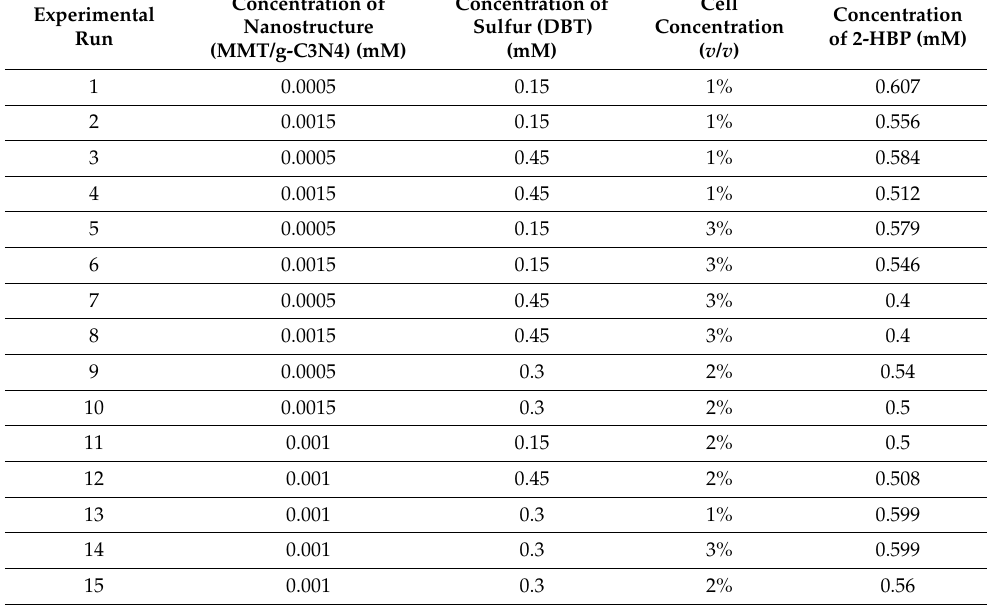
Table 2. The results of CCD for three factors (concentration of nanostructure (MMT/g-C3N4), concentration of sulfur and cell concentration) and the production of 2-HBP by R. sp. strain IGTS8. Concentration of Experimental Run